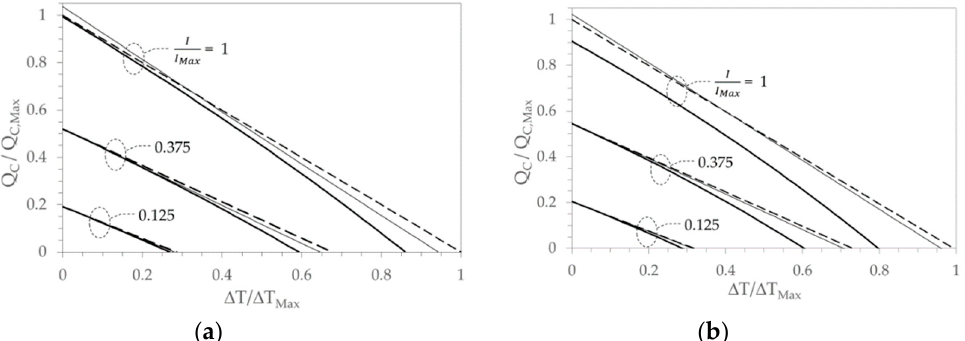
Figure 10. T H = 323.15 K . Relative cooling capacity Q C / Q Max against the relative temperature di ff erence ∆ T / ∆ T Max for di ff erent relative feeding currents I / I MAX . The thick solid lines represent the performed experiment, the dashed lines refer to thermoelectric properties independent of temperature, the thin solid lines indicate the scenario in which the Seebeck coe ffi cient depends on the temperature, while both the electrical resistivity and the thermal conductivity are temperature independent: ( a ) case ( i ); ( b ) case ( ii ).